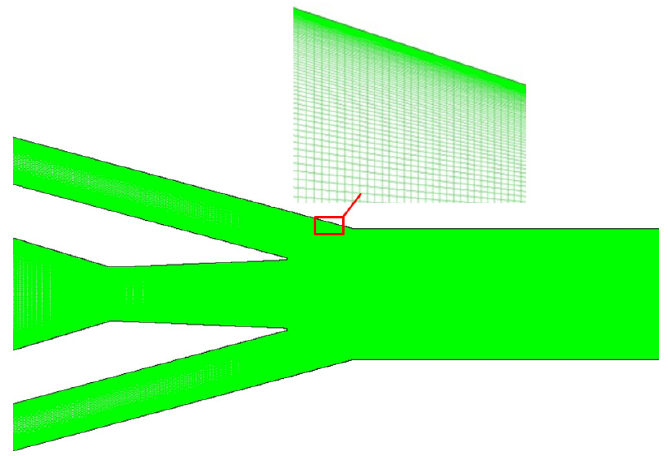
Figure 2. Mesh of the flow region.